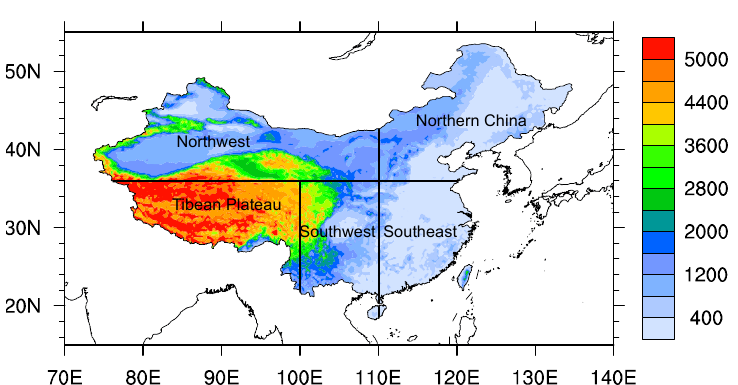
Figure 1. Hereinto, Northwest China and Southwest China are the two regions with the topography ranging from the 400 m to 4000 m. In most areas of the TP, the altitude is above 4000 m.